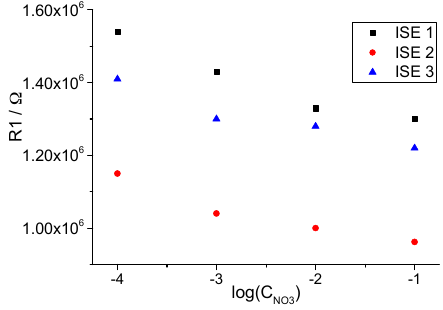
Figure 5. The dependence of the R1 value on the KNO 3 concentration in the solution.